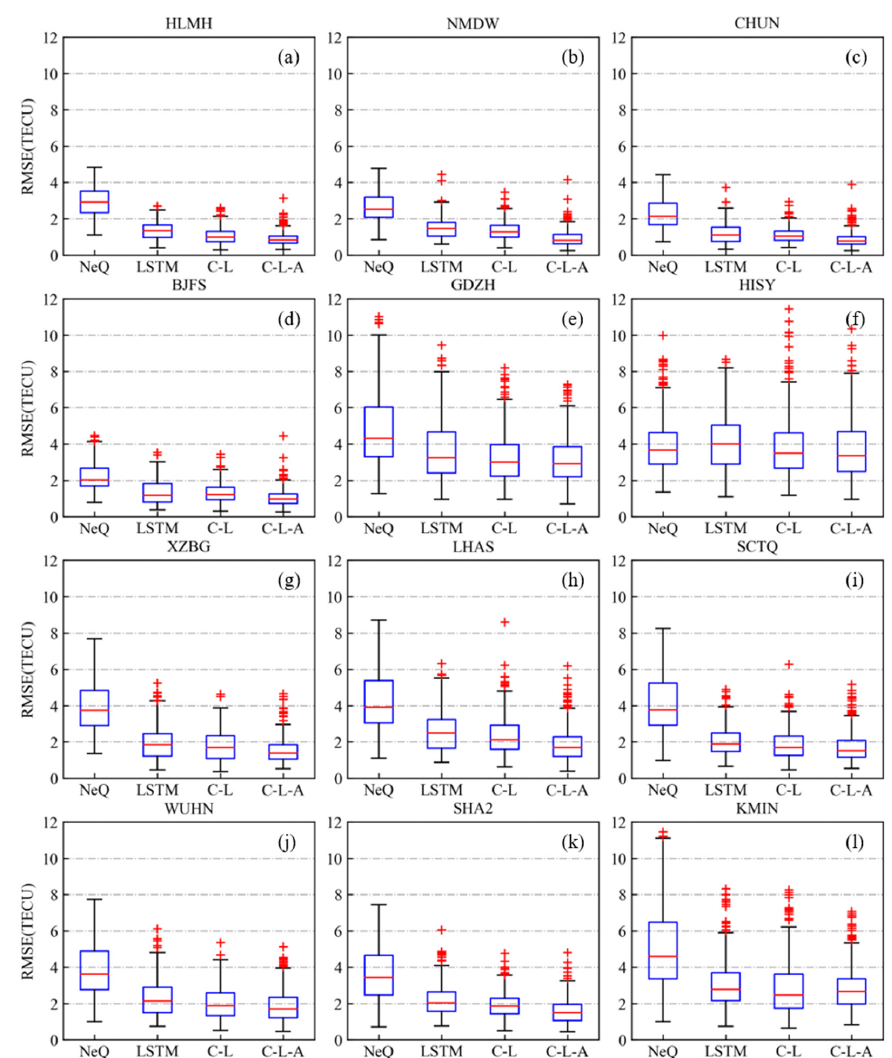
Figure 7. ( a – l ) The RMSE of NeQuick, LSTM, CNN-LSTM, and CNN-LSTM-Attention models from 12 stations in the test set. The top and bottom black bars represent the maximum and minimum values, respectively. The upper and lower edges of the blue box represent the upper quartile and the lower quartile, respectively. The middle red bar represents the median, and the red plus sign represents the outlier.